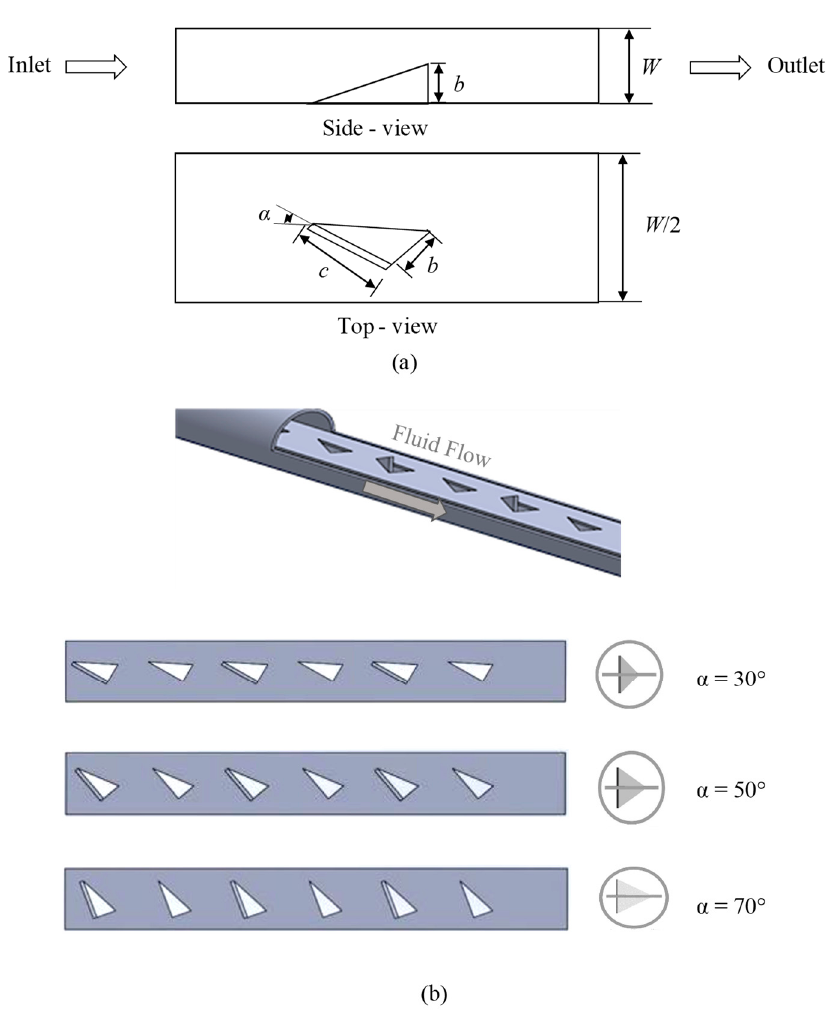
Figure 1. Geometrical definitions; ( a ) nomenclature of PDWVG; ( b ) PDWVGs with attack angle variation. Table 2. Thermo-physical properties of the hot and cold water at the inlet. Fluid Temperature [K] c p [kJ/kg · K] Hot